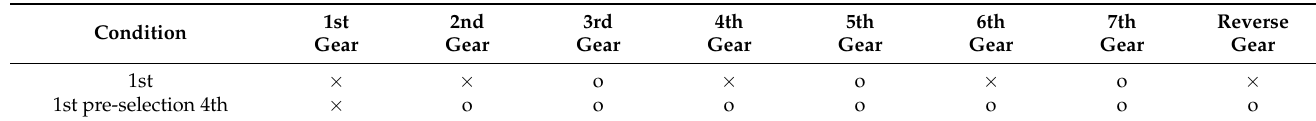
Table 1. Possible rattling gears under two working conditions. (Note: “o” means rattling is possible; Table 1 Possible rattling gears under two working conditions. “ × ” means rattling is impossible).